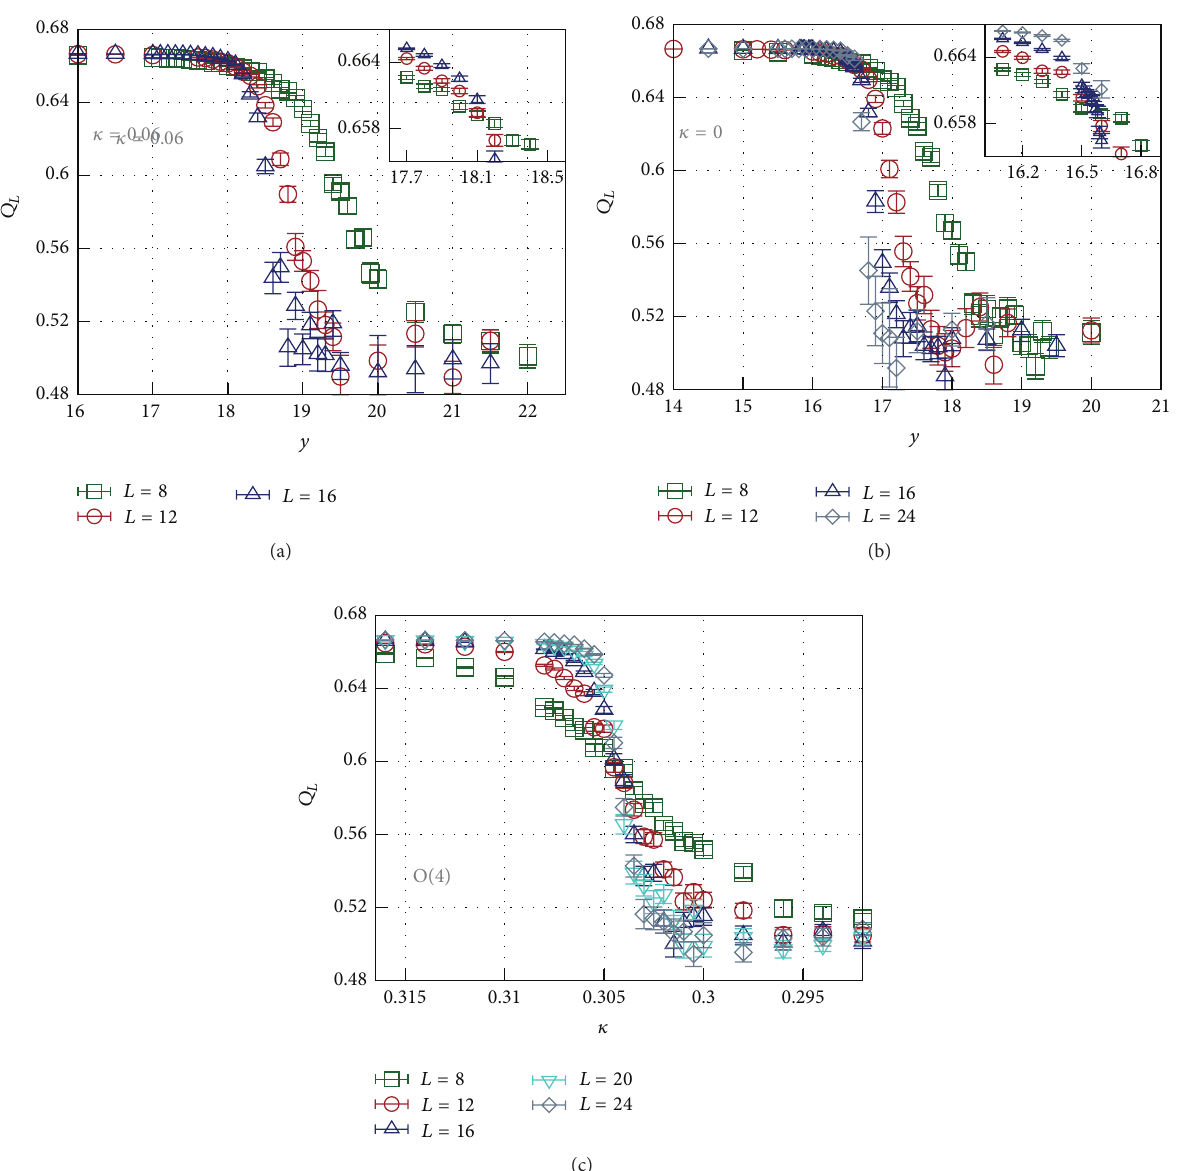
value for all setups considered here. Still, 𝑄 𝐿 obtained in the Higgs-Yukawa model differs from the one in the O(4)